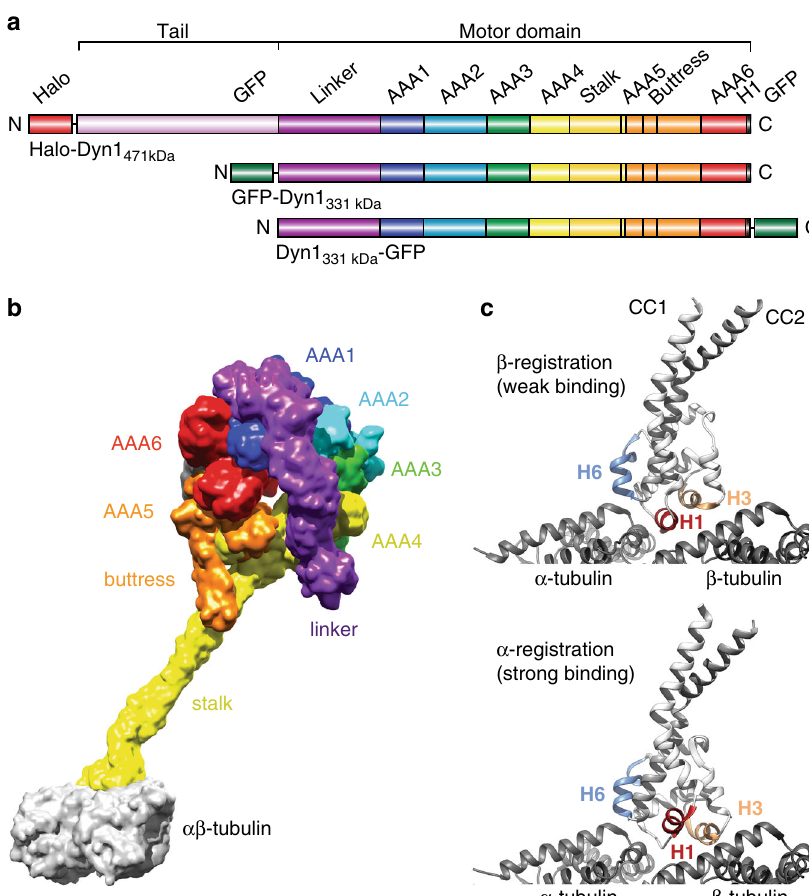
Fig. 1 Domain organization of cytoplasmic dynein and low- and high-af fi nity MT-bound states of the dynein MTBD. a Organization of the full-length cytoplasmic dynein heavy chain (HC) with an N-terminal Halo-Tag, Halo-Dyn1 471kDa (a.a. 1 – 4092) and the tail-truncated monomeric constructs, GFP-Dyn1 331kDa and Dyn1 331kDa -GFP (a.a. 1219 – 4092). b Dynein MD bound to α / β -tubulin in the strong binding state (merged from PDB entries 3VKG and 3J1T; see Supplementary Note 1). c MT-bound MTBD in the weak MT-binding β -registration of the stalk helices (top, PDB entry 3J1U) and in the strong MT-binding α -registration (bottom, PDB entry